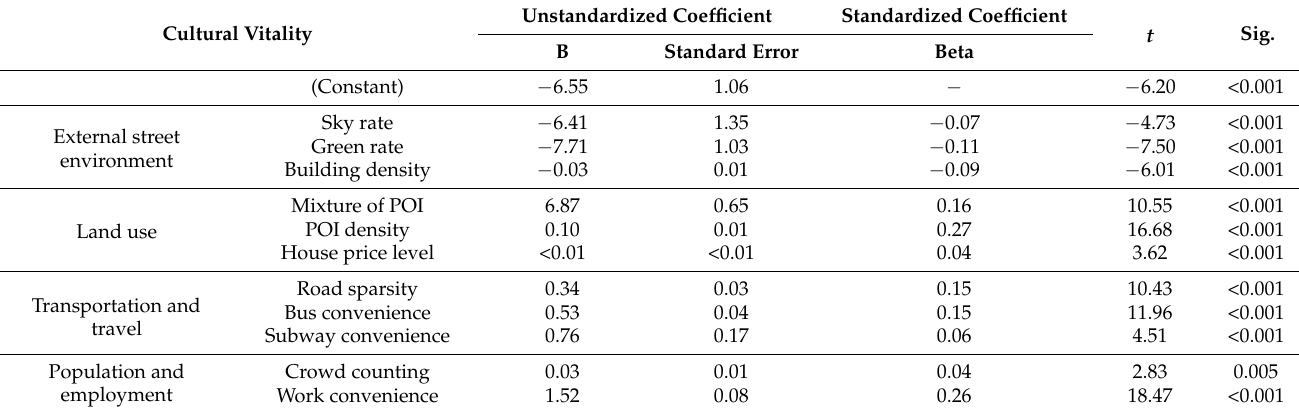
Table 8. Regression coefficient results for cultural